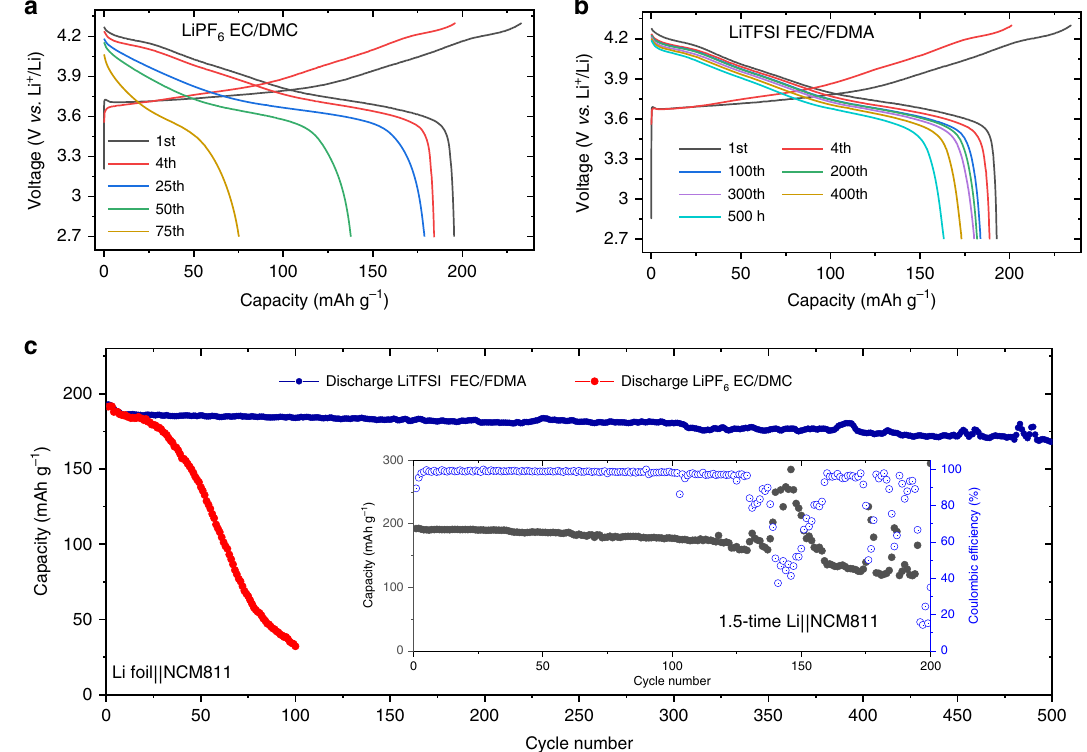
Fig. 6 Electrochemical behavior of full cells using NCM811 as cathode. a , b Galvanostatic charge – discharge curves of Li||NCM811 cells in 1 M LiPF 6 -EC/ DMC and 1 M LiTFSI-FEC/FDMA. c Cycling stability of Li||NCM811 cells at rate of 0.25 C with fi rst three cycles at 0.1 C. The inset shows the cycling history of the Li||NCM811 full cells with negative to positive electrode capacity ratio of